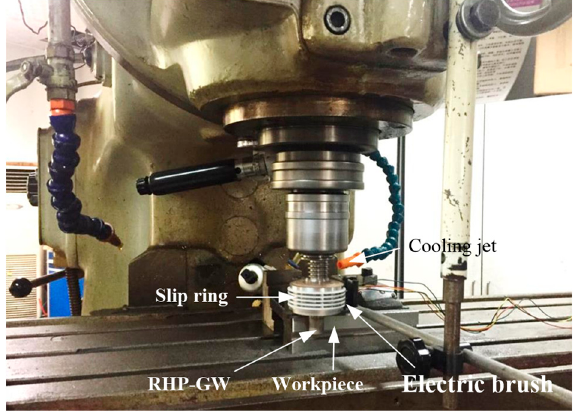
Figure 10. Experimental setup.